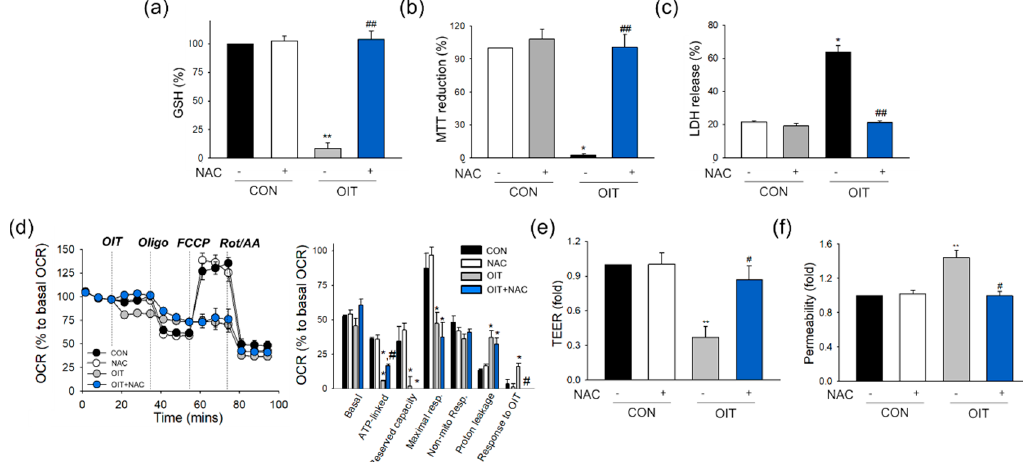
Figure 5. Reversal effects of N-acetyl L-cysteine (NAC) against OIT-mediated effects on GSH level, cell viability, mitochon- drial metabolic activity, and endothelial barrier function. ( a – c ) bEnd.3 cells were pre-treated with NAC for 2 h, and then, the media were replaced by OIT (25 µ M)-containing media. ( a ) The level of reduced GSH was determined in cells 24 h after OIT treatment ( n = 3). ( b , c ) The extent of ( b ) MTT reduction and ( c ) LDH release was measured in cells 24 h after OIT (25 µ M) treatment ( n = 3). ( d ) bEnd.3 cells were pre-treated with NAC for 1 h and incubated for an additional 1 h with assay media containing NAC during degassing. OIT was then acutely injected into the cells. The profile of the OCR was plotted, and parameters for mitochondrial respiration were calculated ( n = 3–4). ( e , f ) Measurement of ( e ) TEER and ( f ) FITC-dextran permeability was conducted in bEnd.3 cells 24 h after OIT (25 µ M) treatment with or without NAC pre-treatment. Data are presented as mean ± SEM. * p < 0.05, ** p < 0.01 vs. CON (control); # p < 0.05, ## p < 0.01 vs. OIT-treated